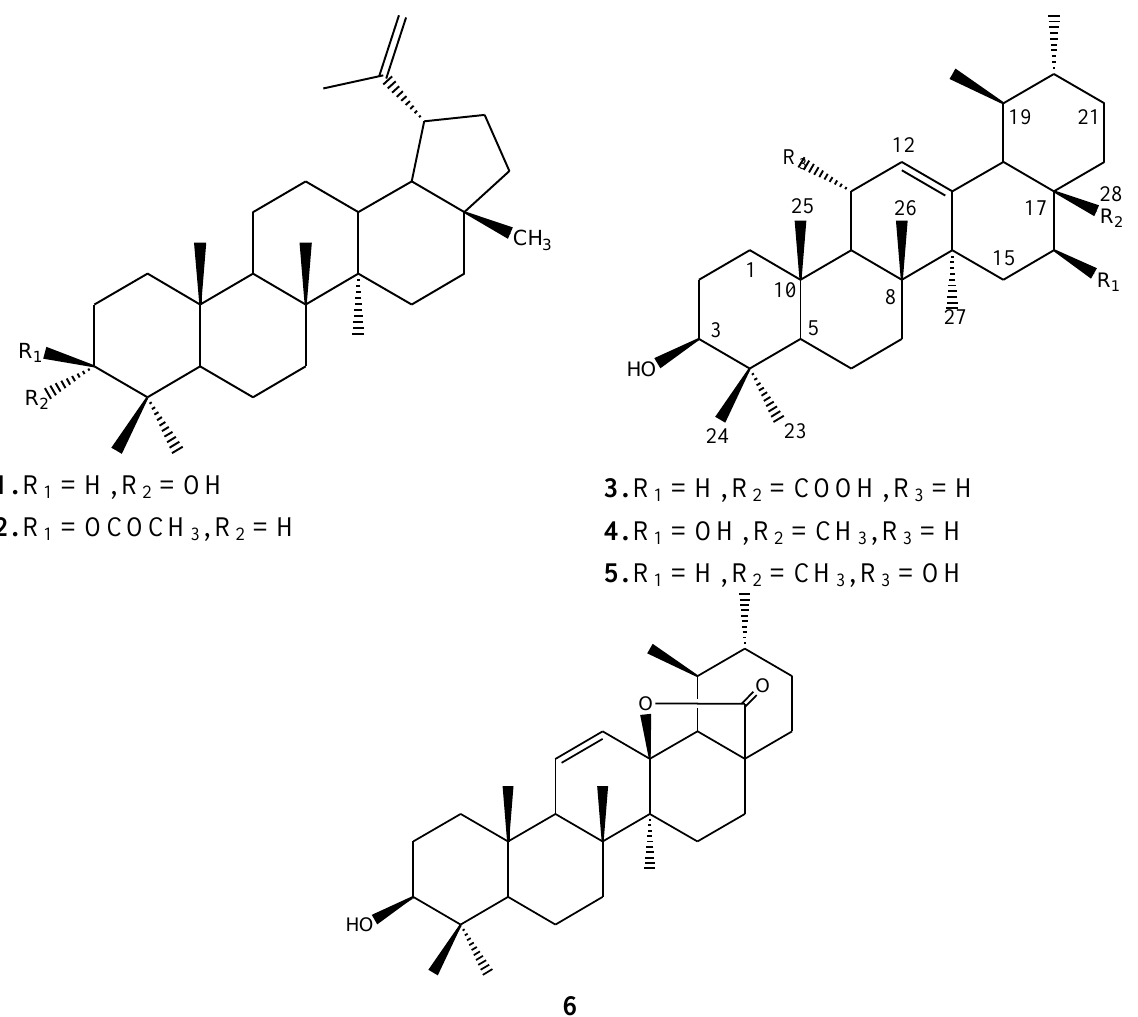
Figure 1. Structures of the triterpenoid compounds 1 – 6